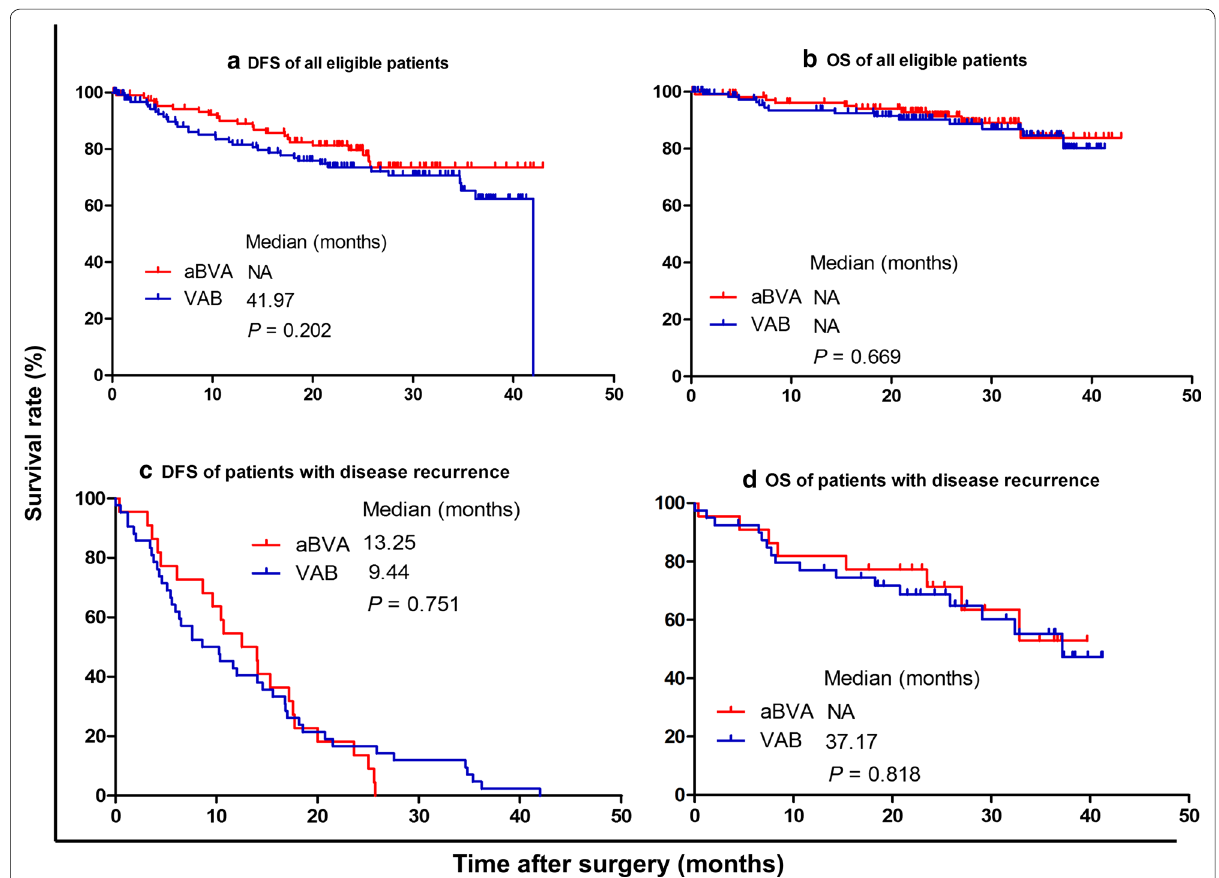
Fig. 3 DFS and OS of all eligible patients and patients with disease recurrence between the aBVA and VAB cohorts. a DFS of all patients. b OS of all patients. c DFS of patients with disease recurrence. d OS of patients with disease recurrence. DFS disease‑free survival; OS overall survival; aBVA RUL with the dissecting order of the posterior ascending arterial branch [a], followed by the right upper bronchus [B] and pulmonary vessels [VA]; VAB RUL with the dissecting order of the right upper pulmonary veins and arteries [VA], followed by the right upper bronchus [B]; NA not arrived